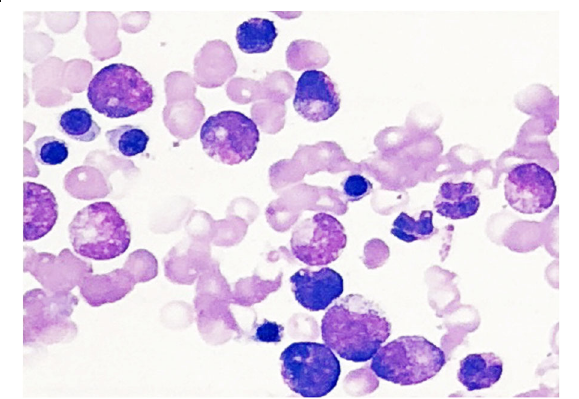
Fig. 1 Bone marrow aspiration. Mononuclear histiocyte with engulfed erythrocyte was observed. G=64.5%, E=31.5%,